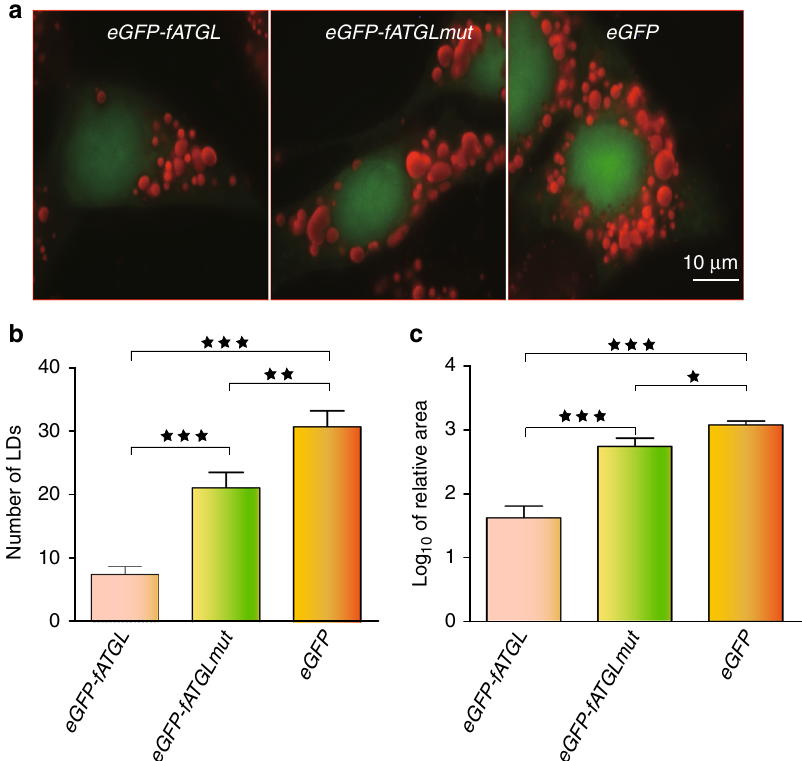
Fig. 2 Functional validation of ATGL AGT321GGT substitution. a The images were taken from the ORO stained human HeLa cells after the fi xation with 3.7% formaldehyde: the wild type ( eGFP-fATGL ), mutant type ( eGFP-fATGLmut ) and negative control ( eGFP ). Lipid droplet numbers b and areas c were compared between the wild and mutant types ( N = 90). * P < 0.05, ** P < 0.01, *** P < 0.001 by t test. Error bars indicate s.e.m. Source data are provided as a Source Data fi